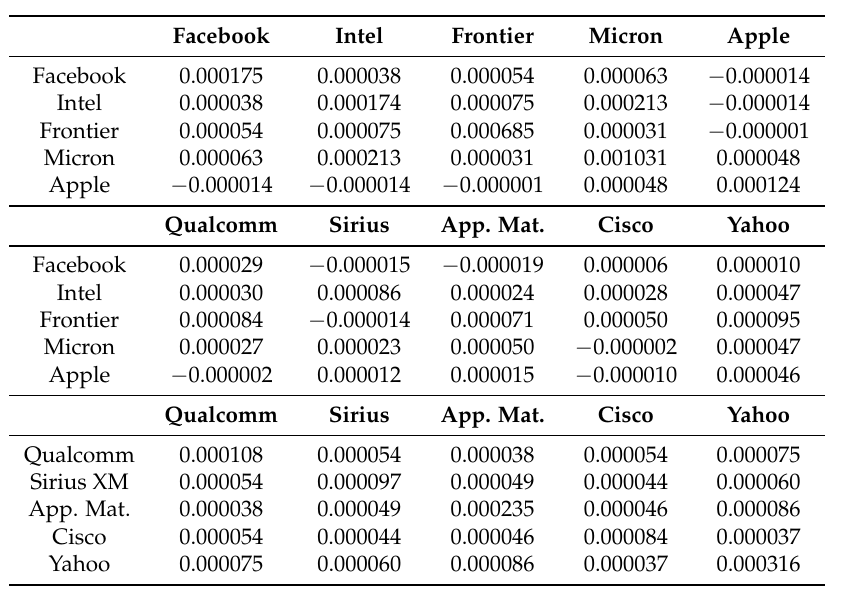
Table 2. Covariance matrix of the returns.